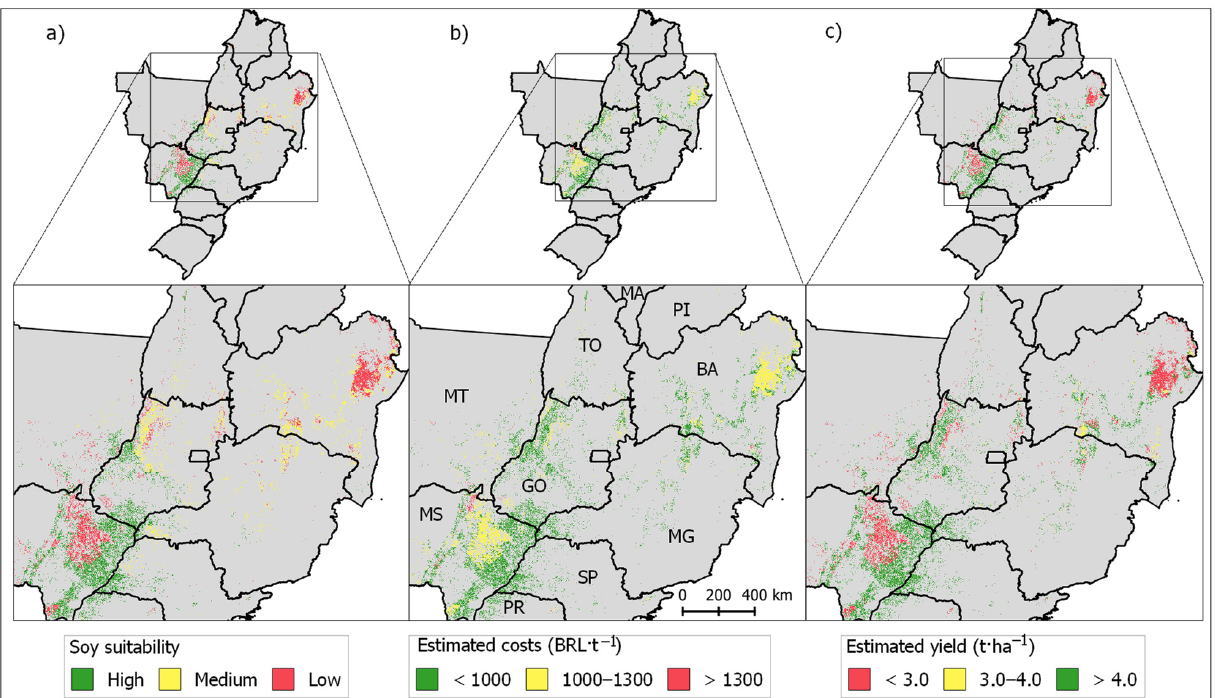
Figure 4. ( a ) Suitability map, ( b ) expected costs, and ( c ) estimated yields for soybean production in the 12 Brazilian states assessed, indicating only contiguous areas with at least 100 hectares, in which soy cropping could be full mechanized.